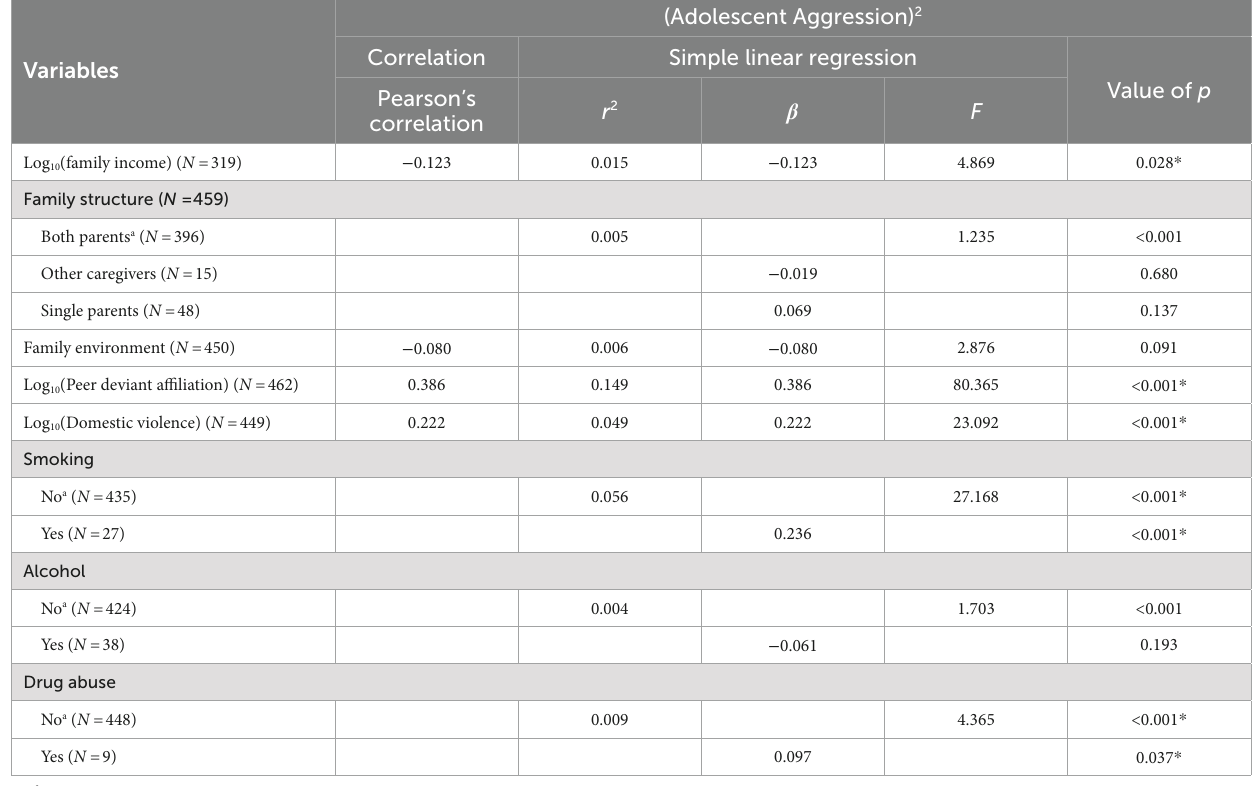
TABLE 3 Association between social factors and (adolescent aggression) 2 by Pearson’s correlation and simple linear regression.